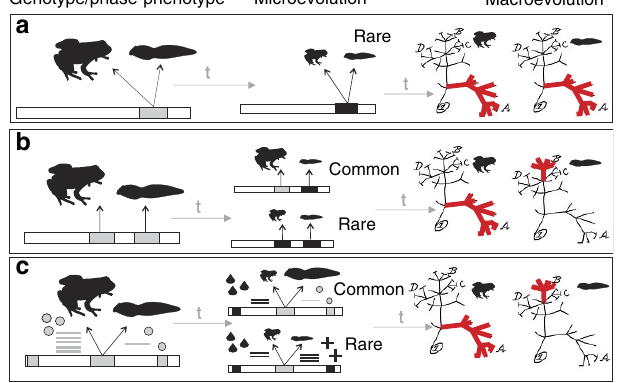
Figure 1 | Predictions for coupled and uncoupled trait evolution in life-history phases. ( a ) ‘Phase-Pleiotropy’ under coupled evolution. The same genes contribute to tadpole and adult morphological features (here: body size). Non-synonymous DNA substitutions are rare due to phase- specific selective regimes. The same genes are equally expressed across phases. Phenotypic evolutionary rates are correlated and rate changes are concentrated on the same parts of the phylogeny (t represents evolutionary time). ( b ) ‘Phase-Polygeny’ model 1: uncoupled evolution with different genes coding for tadpole and adult phenotype. Non-synonymous DNA substitutions are common due to phase-specific selective regimes. Genes are unequally expressed across phases. Parallel genetic changes are rare, only if favored by selection across phases, and facilitated by linkage. unequally distributed on the phylogeny. ( c ) ‘Phase-Polygeny’ model 2: among tadpole and adult phenotype. The same genes contribute to tadpole and adult phenotype, but are regulated/expressed differently (mRNA— bars, epistatic gene products—tear drops, crosses, grey